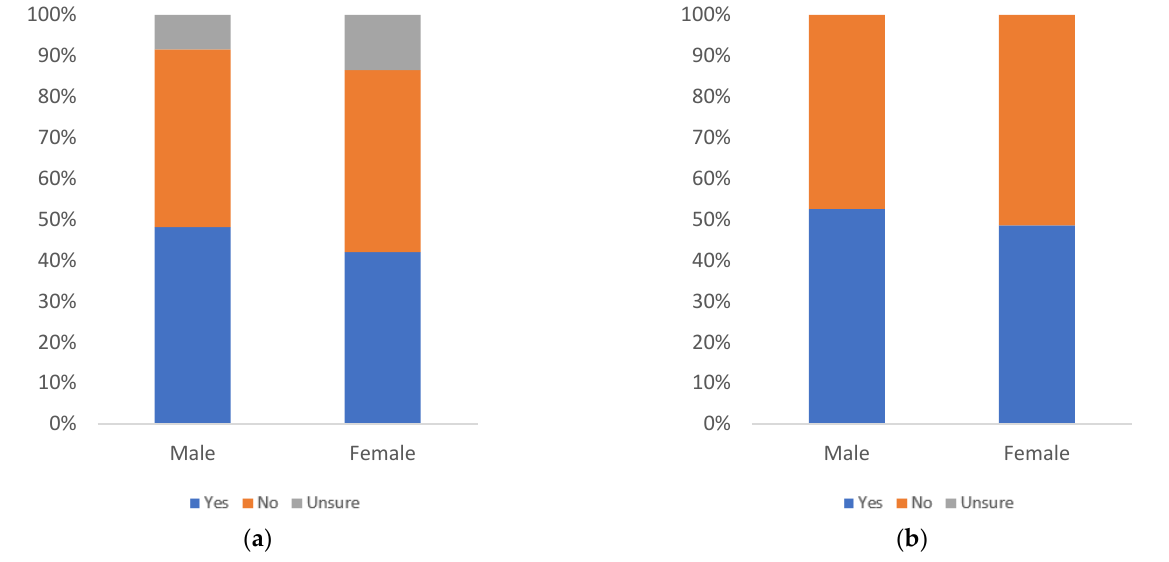
Figure 26. Label annoyingness, by gender: ( a ) with uncertain respondents (left) and ( b ) without uncertain respondents (right).